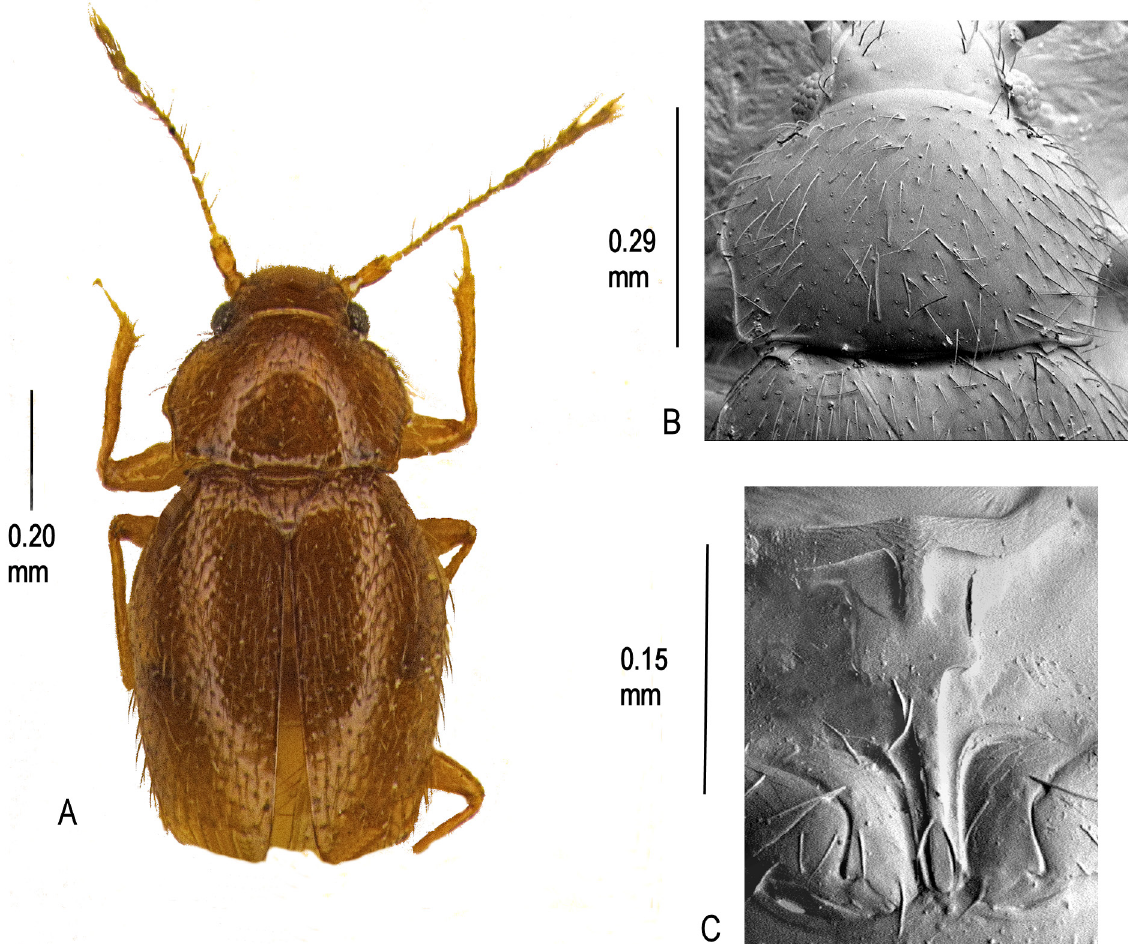
Fig. 97 . Cissidium obscenum sp. nov. A . Habitus. B . Pronotum, × 460. C . Mesoventrite showing median process of collar, mid-keel and keel, ×